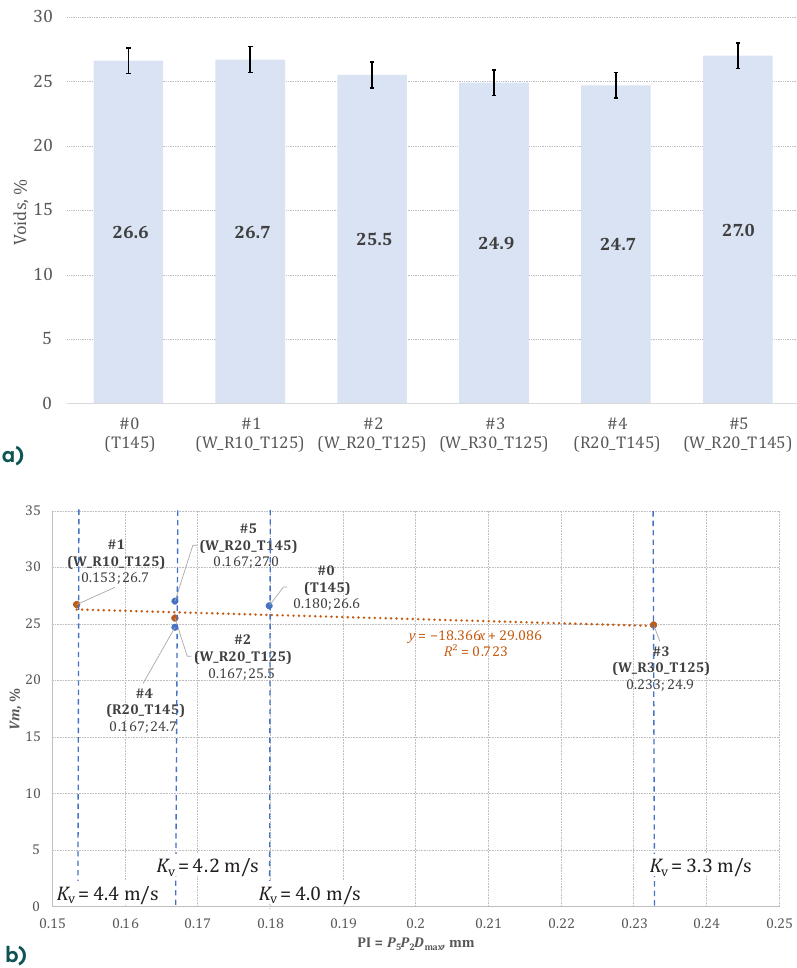
Figure 2. Results in terms of physical characteristics: a) air void content, b) relation between air void content and permeability index PI (values of the vertical permeability deduced from Equation 2 are reported along dashed lines for each PI